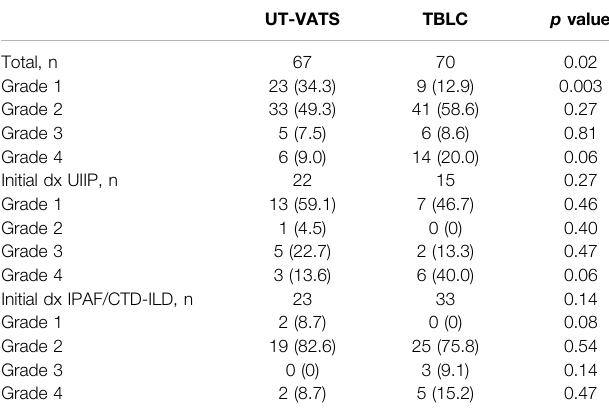
TABLE 3 | The distribution of pathological diagnosis in IPAF/CTD-ILD patients. UT-VATS ( n = 29) – TBLC ( n = 36)